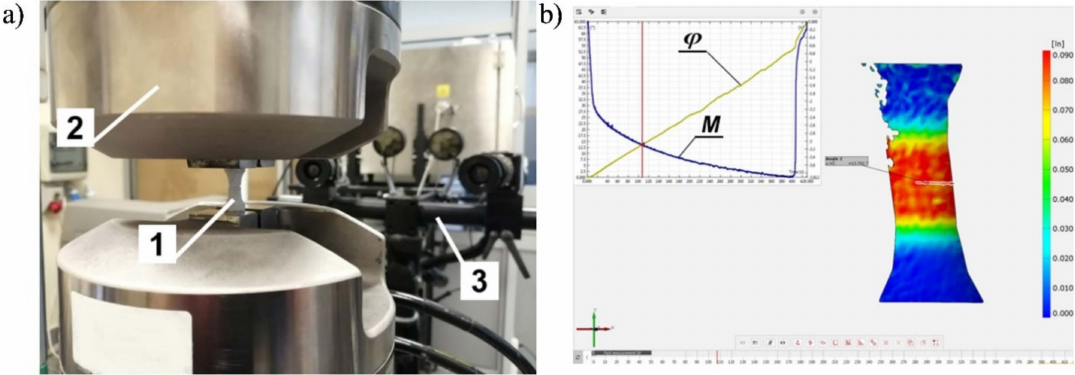
(1—specimen; 2—hydraulic grip; 3—ARAMIS 3D 4M system), ( b ) Vision system dialogue (ARAMIS 3D 4M).